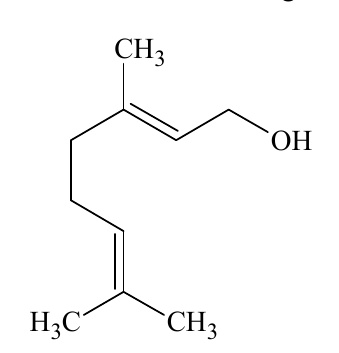
Figure 8. Chemical structure of